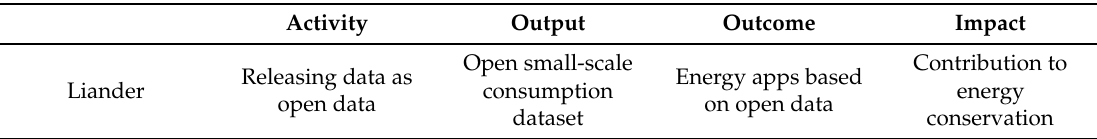
Table 1. Example of output-activity-outcome-impact for